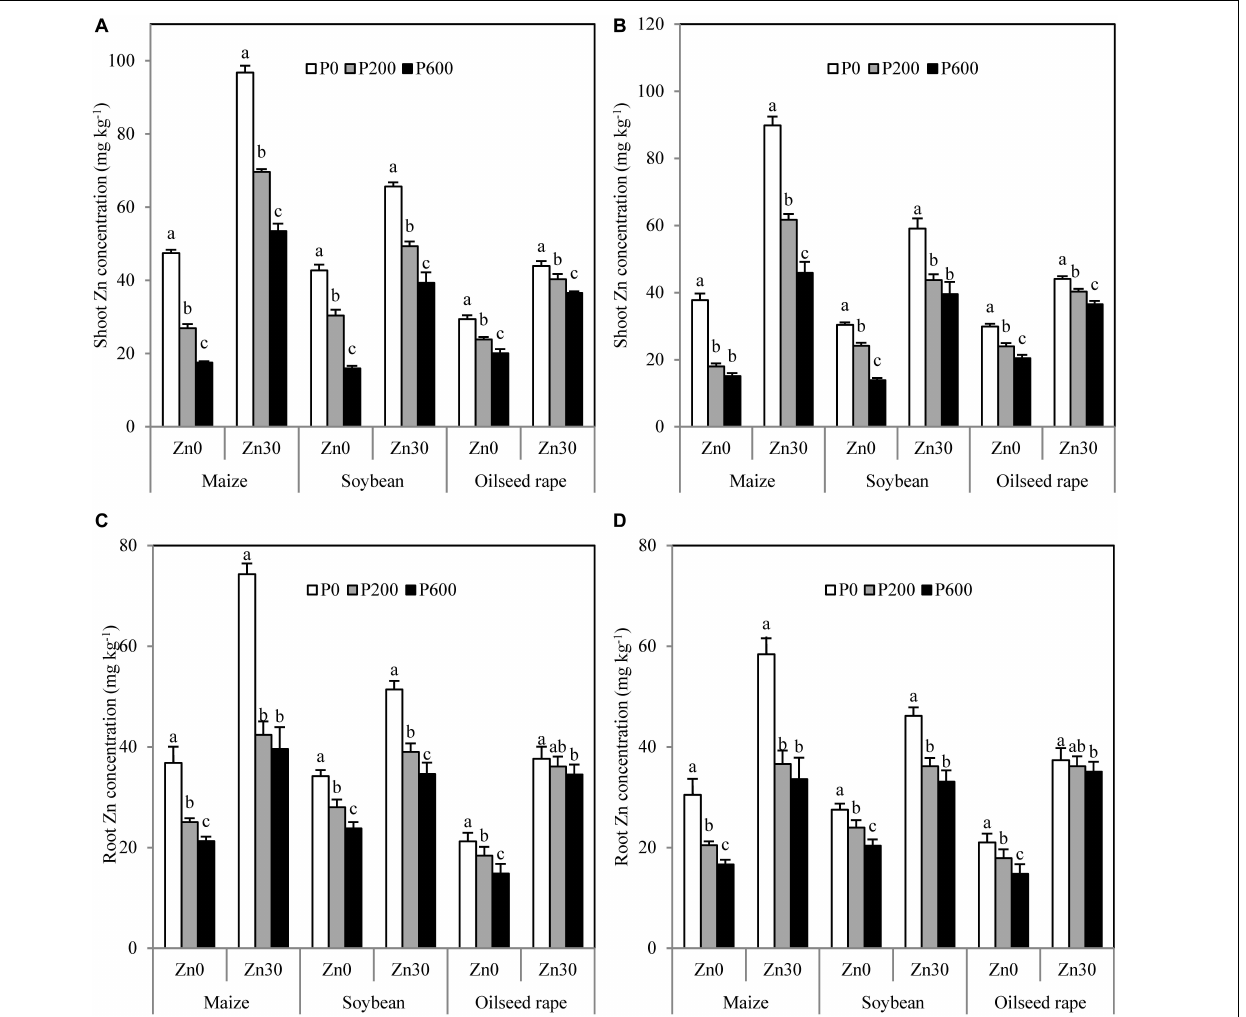
FIGURE 1 | Zn concentration in shoots and roots of maize, soybean, and oilseed rape affected by P and Zn applications without benomyl (A,C) and with 0.4 g benomyl kg − 1 soil (B,D) addition, respectively. Values are means of three replications. The same lowercase letter indicates no significant difference among P application levels ( P < 0.05). Zn0 and Zn30 represent 0 and 30 mg Zn kg − 1 soil rates, respectively. P0, P200, and P600 represent 0, 200, and 600 mg P kg − 1 soil rates,